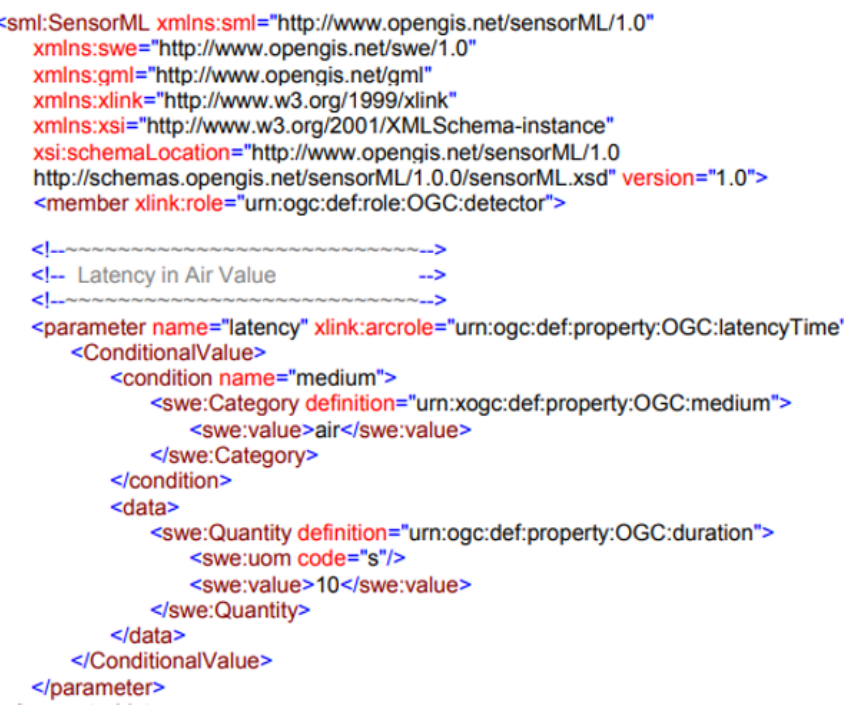
Figure 4. Example of XML for defining a sensor latency value.